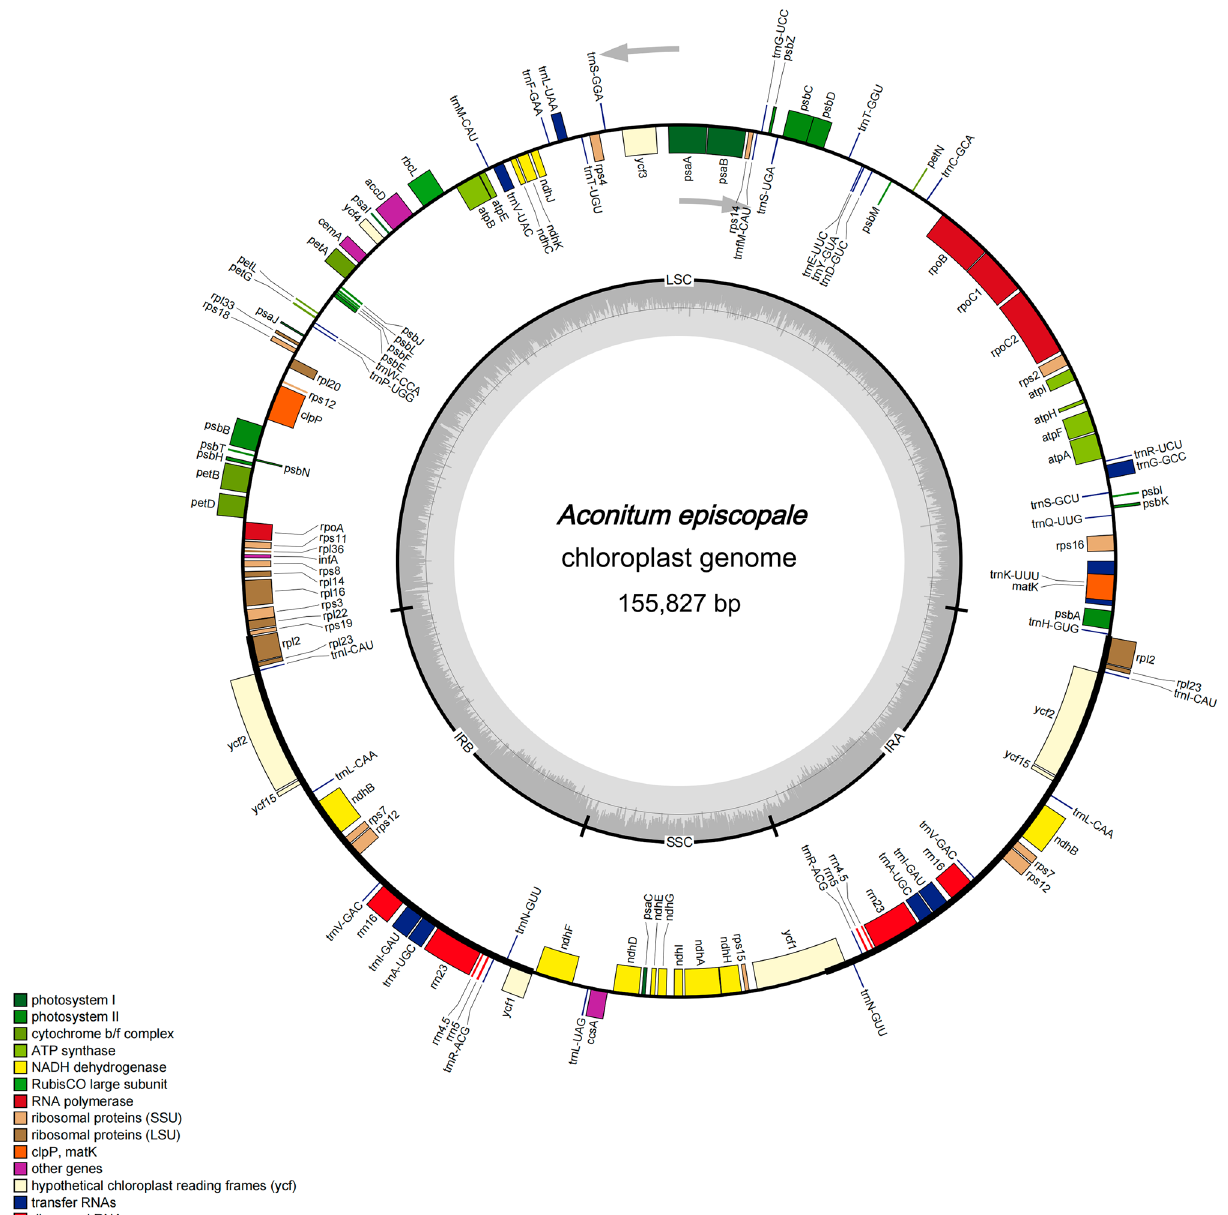
Figure 2. Chloroplast genome map of A. episcopale . Genes shown inside the circle are transcribed clockwise, and genes located outside the circle are transcribed counter-clockwise. Genes belonging to different functional groups have been colour-coded. The dashed area in the inner circle indicates the GC content of the chloroplast